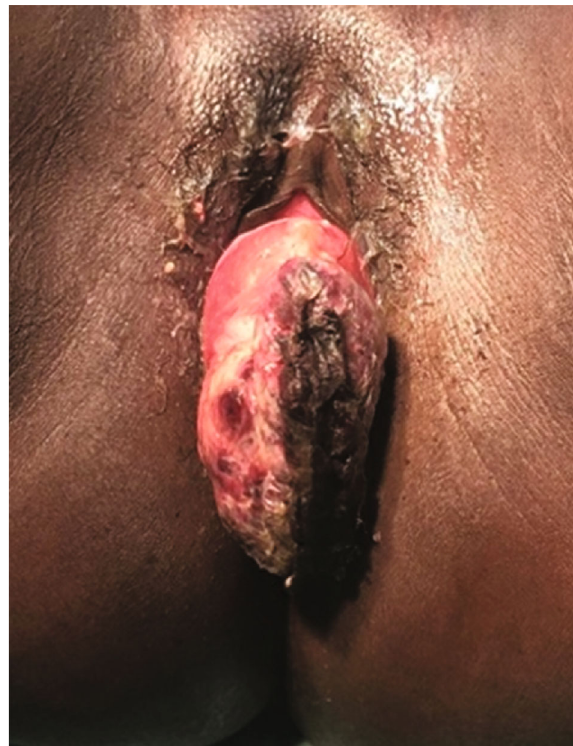
Figure 3: Prolapsed, exophytic cervical mass measuring 8 cm × 8 cm which redeveloped after initial excisional